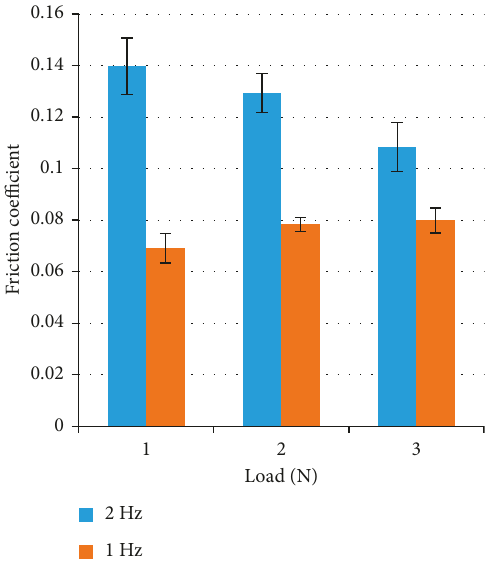
Figure 3: Effect of load under deionized water lubrication